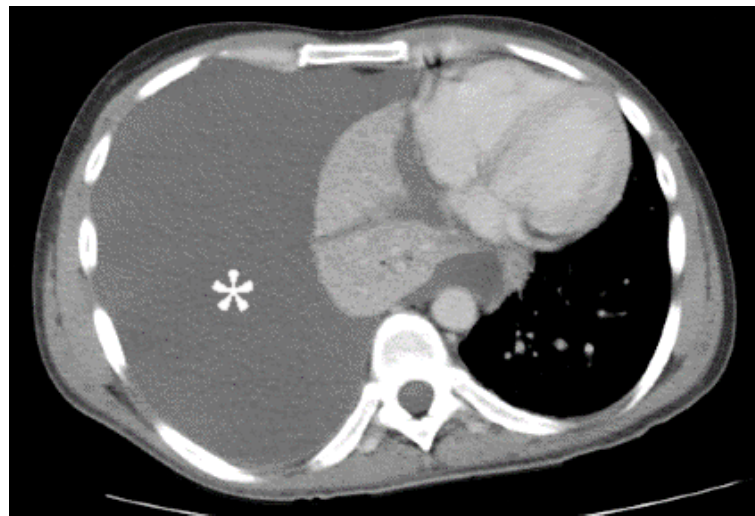
Figure 4. This is an axial view demonstrating a large right pleural effusion with mediastinal shift leftward demarcated by an